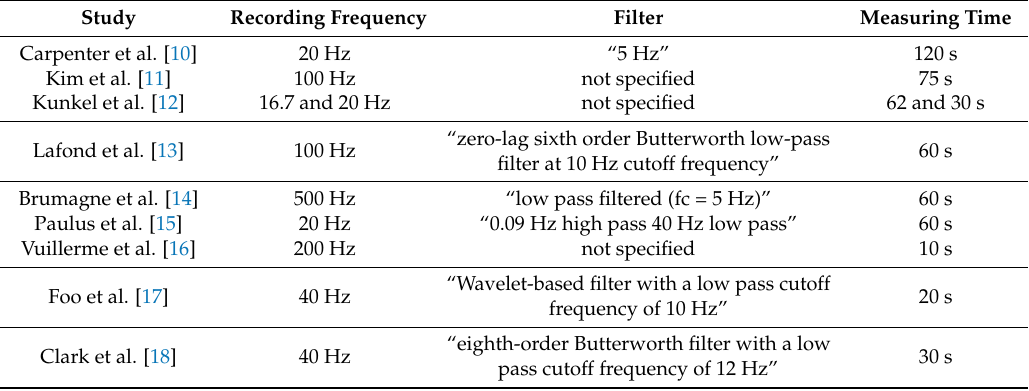
Table 1. Overview of different Measurement strategies and the applied